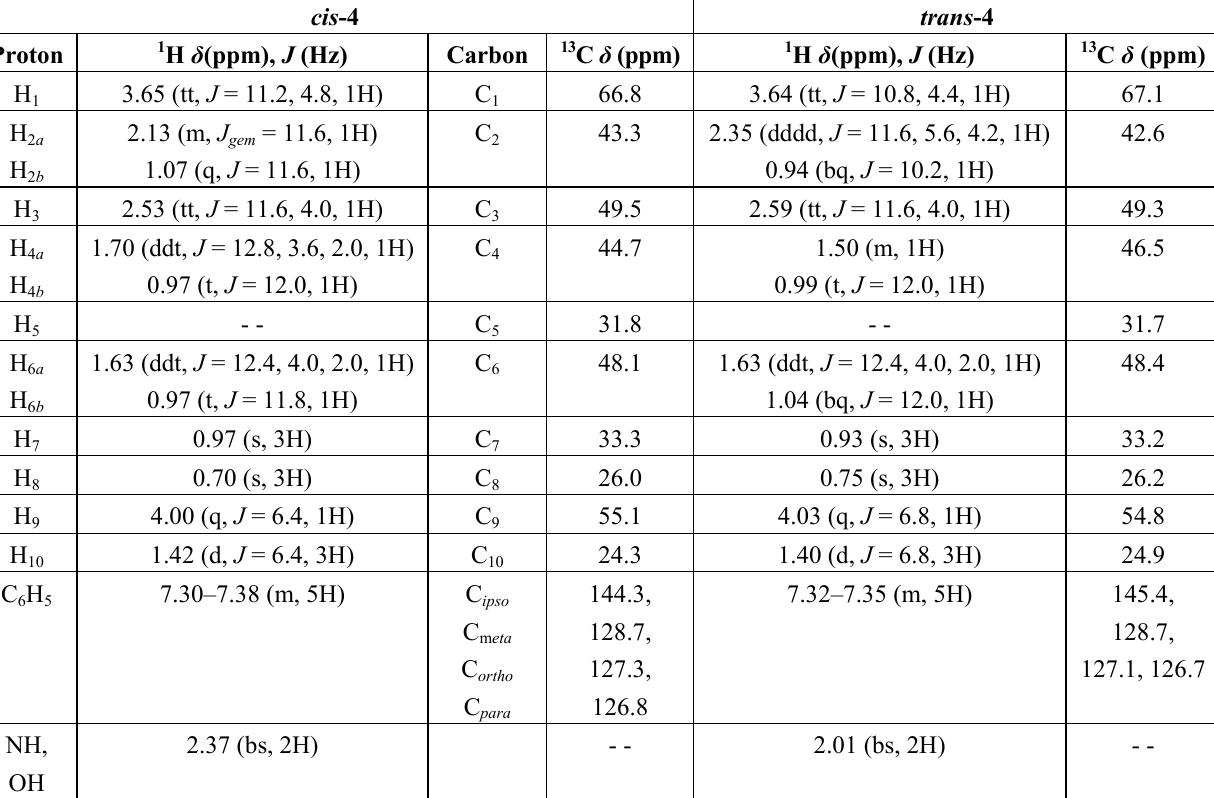
Table 1. 1 H And 13 C-NMR chemical shifts for the compounds cis - 4 and trans - 4 .